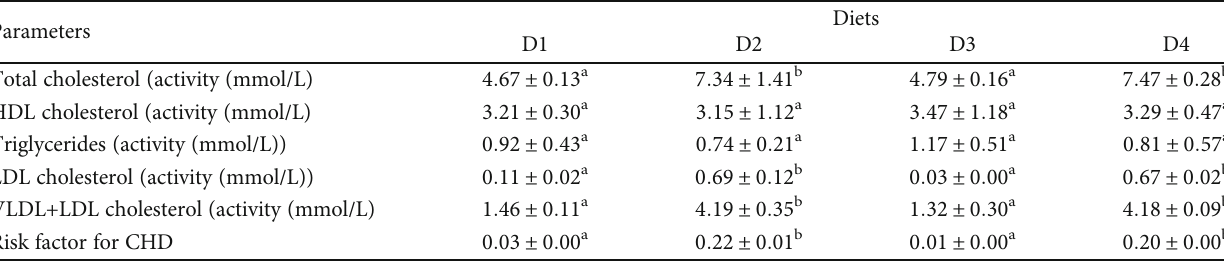
Table 5: E ff ects of treated diets on lipid pro fi le of